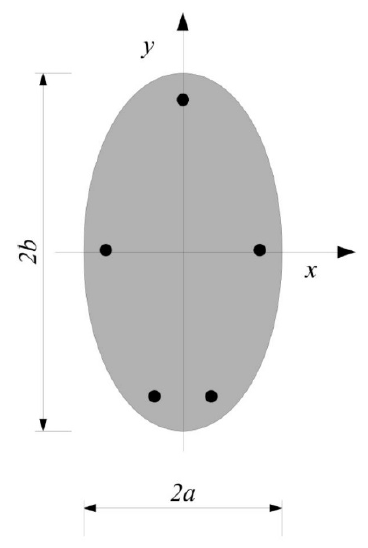
Figure 10. Ellipsoidal cross